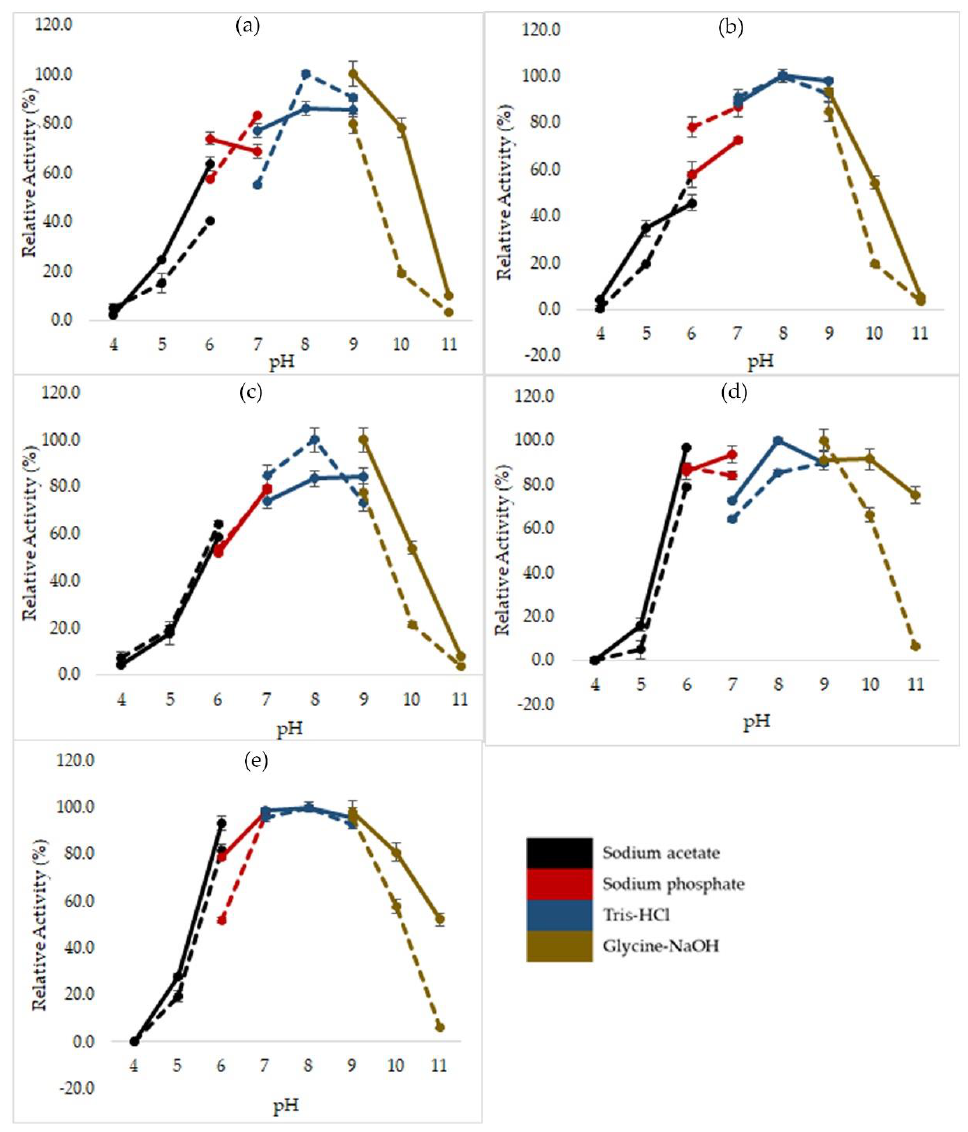
Figure 3. Effects of pH on activity of mutated HT1 lipases. ( a ) D43E. ( b ) T118N. ( c ) E226D. ( d ) E250L. ( e ) N304E. Dashed line represent the activity of lipase in different buffers with different pH values. Straight line represents the residual activity left after treated with buffer at different pH value for 30 min (60 ° C) prior to lipase assay. The enzyme concentration was standardized to 50 µg for each sample. The assay was performed in triplicate using olive oil as substrate. The higher activity of each mutant lipase was recorded as 100%.